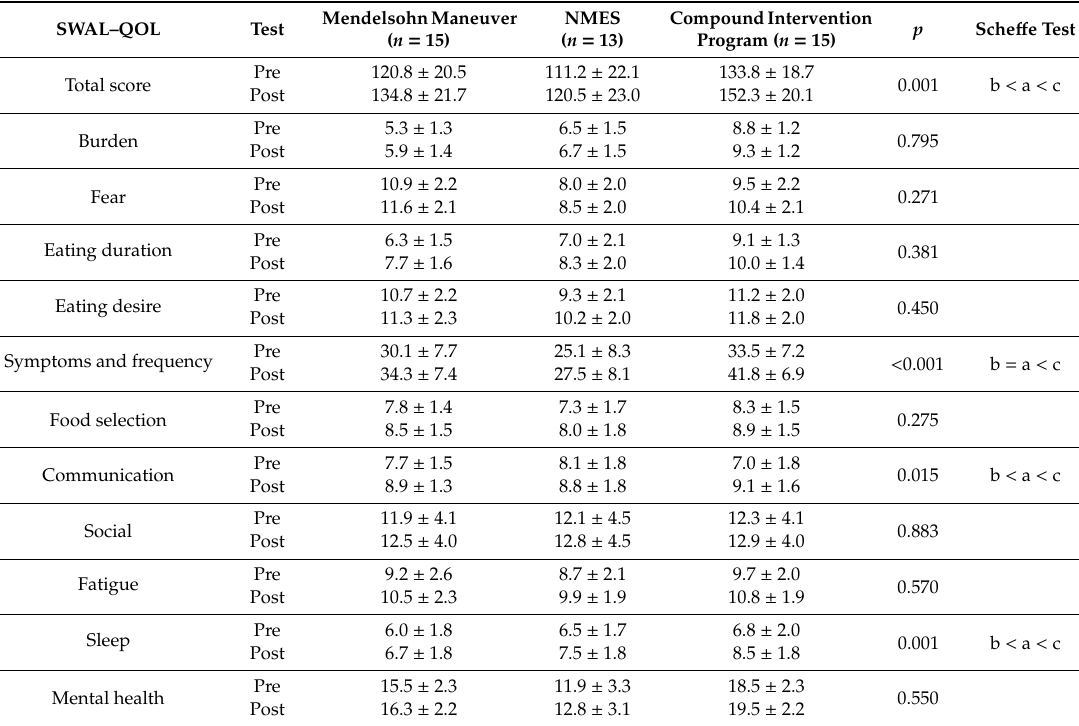
Table 5. Changes in SWAL–QOL according to intervention methods, Mean ±